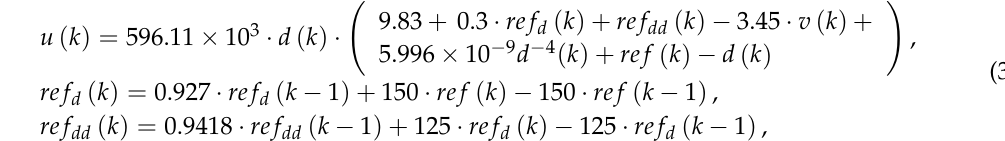
Figure 12. Sensor fusion algorithm with Unscented Kalman Filter for distance measurement of a levitating magnetic object.